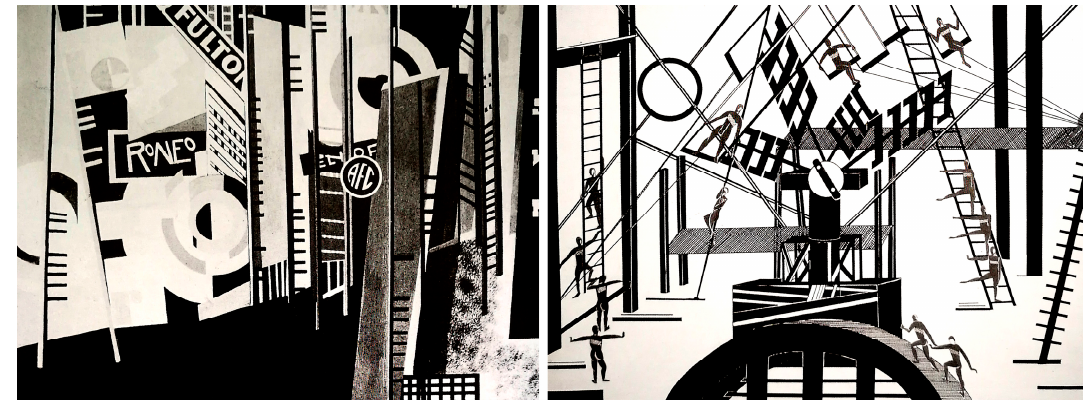
Figure 6. On the left , A. Exter, Project for the set of a film with puppetry, 1922; on the right , A. Exter, Ballet satanique,